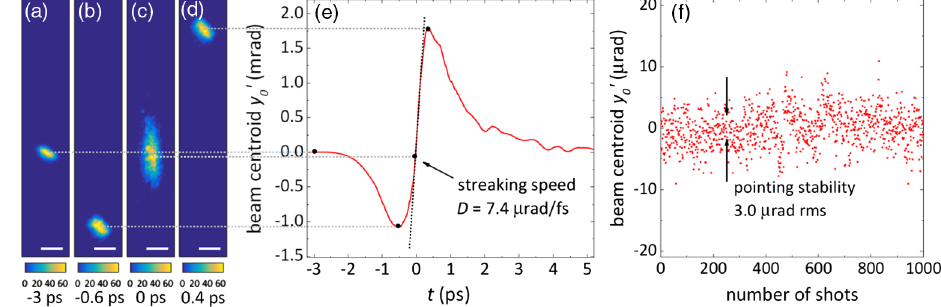
FIG. 2. Experimental data of electron bunch time-of-arrival measurements by THz streaking. (a) – (d) show raw images of streaked electron bunches at different time delays, indicated by dashed lines in (e) showing the beam centroid versus time delay. The scale bars in (a) – (d) correspond to 1.0 mm on the detector screen or 0.31 mrad in divergence. (f) Pointing stability of the electron beam when the THz is